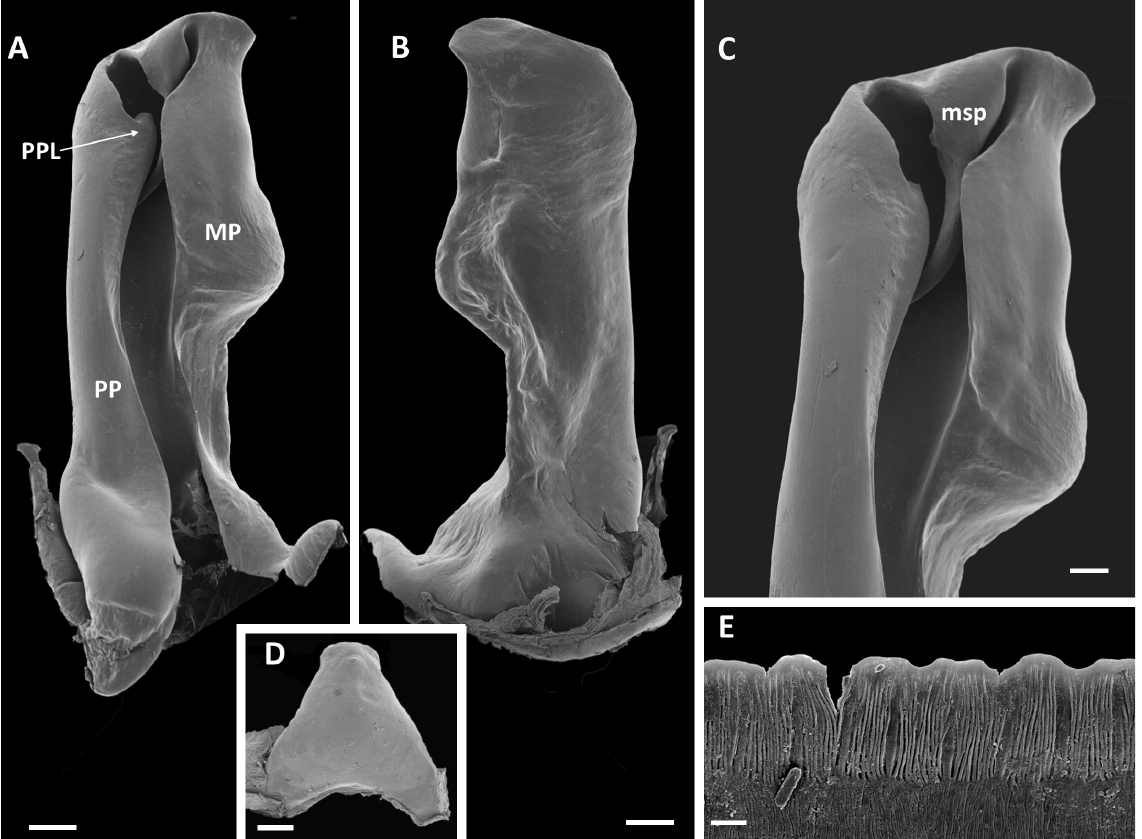
Fig. 10. Aptyctosmilax helenae gen. et sp. nov., holotype, ♂ (NHMD 621701). A–C . Left gonopod coxa. A. Anterior view. B. Posterior view. C. Anterio-lateral view. D . Sternum 9. E . Midbody dorsal limbus. Abbreviations: MP = metaplica; msp = metaplical spinelike process; PP = proplica; PPL = proplical lobe. Scale bars: A–B, D = 0.2 mm; C = 0.1 mm; E = 0.005